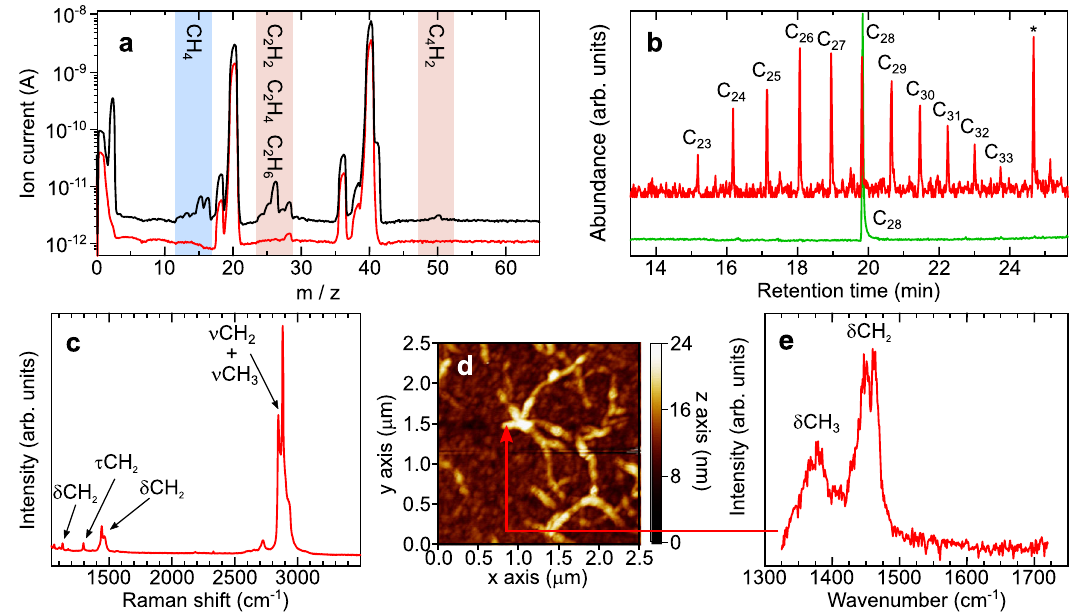
Fig. 2 Spectroscopic composition of the fi bres. a Mass spectrum recorded with a mass quadrupole spectrometer with hydrogen introduced into the system (black line) and without hydrogen introduced into the system (red line — shifted down for clarity). The more intense unlabelled peaks, at 40 and 20 m/z, correspond to Ar (the sputtering gas) and its double ionisation, respectively, whereas the peaks at 36 and 38 m/z are due to stable Ar isotopes. b GC – MS chromatogram obtained from a very dilute solution of the fi bres in acetonitrile collected from an Au substrate (red), showing a distribution of chain lengths centered around C 27 (peak marked * corresponds to a known line from Irganox additive from the micropipette tip). A reference spectrum of a C 28 linear alkane standard (green) was included for comparison. c Representative Raman spectrum recorded from a highly covered sample deposited on a SiO x substrate, with the most characteristic vibrational modes indicated. d AFM topography image of a fi bre-rich area on an Au substrate recorded with AFM-IR (spatial resolution 10 nm) and ( e ) IR spectrum obtained at the marked position in the previous image, from a single nano fi ber at 10 nm resolution, with methyl- and methylene-group vibrations indicated.